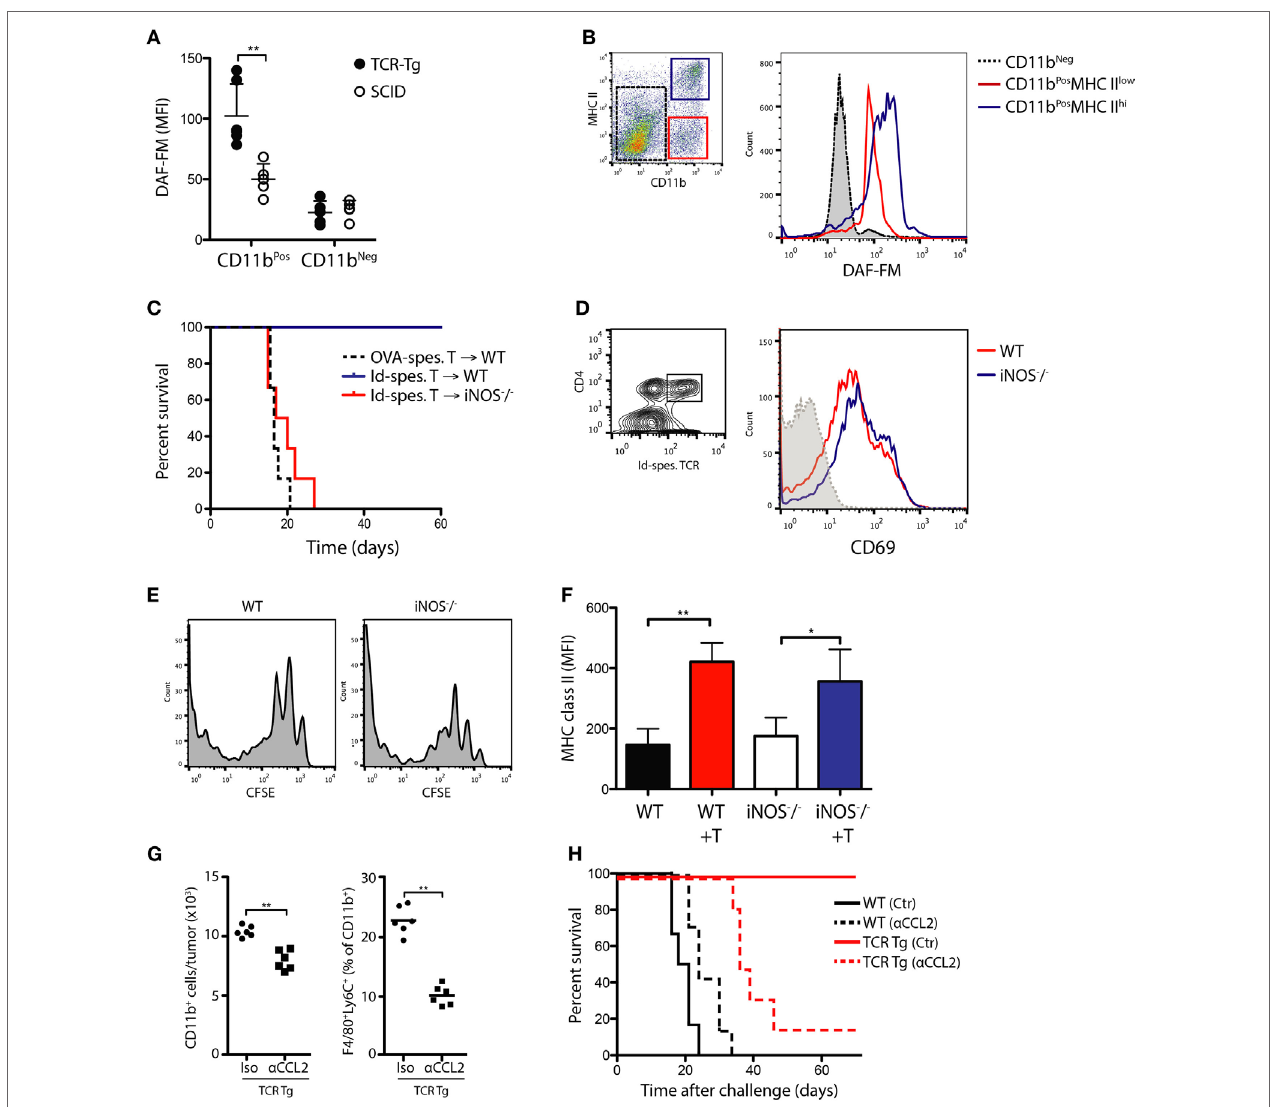
FigUre 3 | In vivo Th1/M1-mediated killing of myeloma cells is mediated by nitric oxide release from tumor-infiltrating macrophages. (a) Flow cytometry quantitation of the nitric oxide indicator DAF-FM in CD11b POS and CD11b NEG cells isolated from Matrigels of mice challenged with MOPC315 cells/Matrigel 12 days previously (mean ± SD, n = 5/group). (B) Distribution of DAF-FM signals in MHC II HIGH and MHC LOW subsets of CD11b POS cells from Matrigel of T cell receptor- transgenic (TCR-Tg) mice. Signal from CD11b NEG cells is shown as a reference. Results are representative of two independent experiments ( n = 6 per group). (c) Survival of MOPC315-challenged wild-type (WT) and iNOS − / − BALB/c mice adoptively transferred with 2 × 10 6 Id-specific CD4 + T cells from TCR-Tg mice or OVA-specific CD4 + T cells from DO11.10 mice ( n = 10–12/group, pooled from two experiments). (D) CD69 expression level on Id-specific CD4 + T cells in tumor-draining lymph node on day + 12 after adoptive T cell transfer in WT and iNOS − / − mice followed by tumor challenge. Results are representative of assays with n = 6 mice per group. (e) CFSE staining in Id-specific CD4 + T cells from lymph nodes of WT or inducible nitric oxide synthase (iNOS)-deficient (iNOS − / − ) mice at day + 12 following s.c. tumor challenge with 1.6 × 10 5 MOPC315 cells. 2 × 10 6 CFSE-labeled T cells were adoptively transferred 24 h before tumor challenge. Results are representative of stainings from six mice per treatment group. (F) Mean MHC II expression level on CD11b + cells isolated from Matrigels on day + 12 following MOPC315 challenge in WT or iNOS − / − BALB/c mice. ( + T) indicated adoptive transfer of Id-specific T cells (mean ± SD; n = 4–5/group). (g) Flow cytometry quantitation of CD11b + cells and macrophages (CD11b + F4/80 + ) within the tumor site on day + 12 following s.c. challenge with 1 × 10 5 Matrigel-embedded MOPC315.4 cells in TCR-Tg mice. Mice were treated with antibodies against CCL2 ( α CCL2) or polyclonal hamster IgG (Iso). n = 5–6 per treatment group. (h) Survival of MOPC315-challenged TCR-Tg and WT mice treated with α CCL2 or isotype control mAb. n = 5–6 per treatment